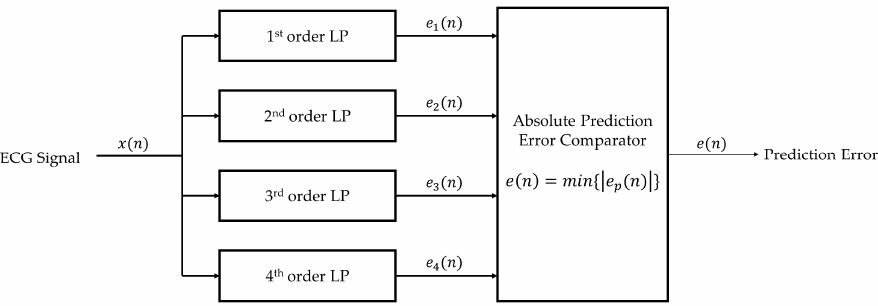
Figure 2. Block diagram of the prediction error-based adaptive linear prediction.